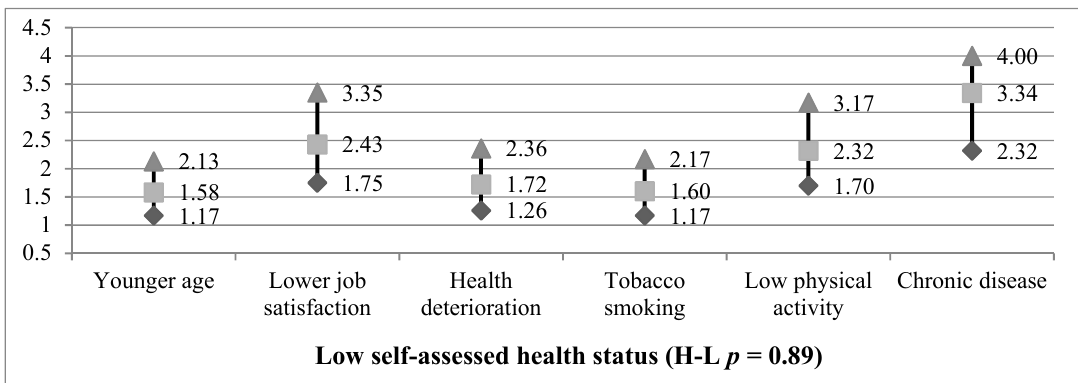
Figure 1. Odds ratio and its 95% confidence interval for low self-assessed health status and particular independent variables ( N = 905). H-L — Hosmer – Lemeshow test; p— statistical significance .